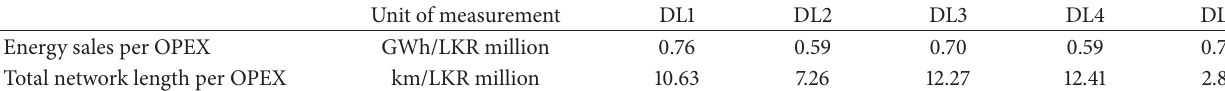
Table 11: Energy sales per OPEX and total network length per OPEX.